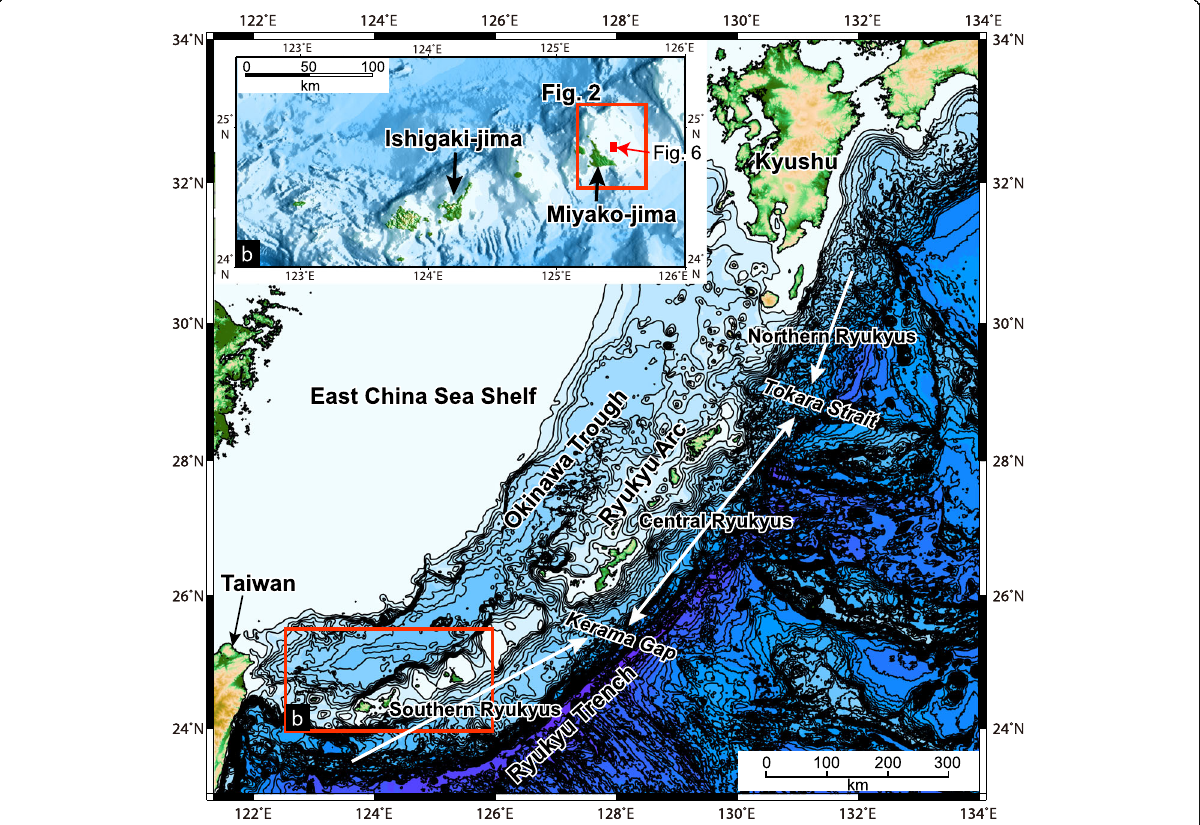
Fig. 1 Bathymetric map of the Ryukyu Island Arc along the Ryukyu Trench and around the study area (right bottom). Submarine topographic relief data are from the JTOPO30v2 provided by the Marine Information Research Center, Japan Hydrographic Association. The study area is located around